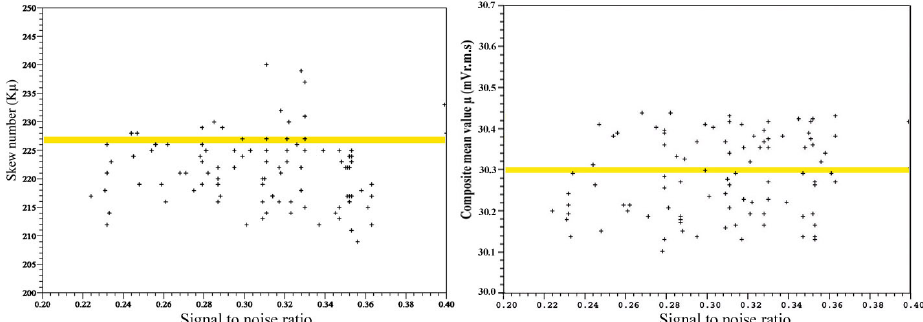
Fig. 8. Distributions of skew number K µ (left panel) and composite mean µ (right panel) versus SNR (simulation S1). The experimental values are highlighted by yellow lines.